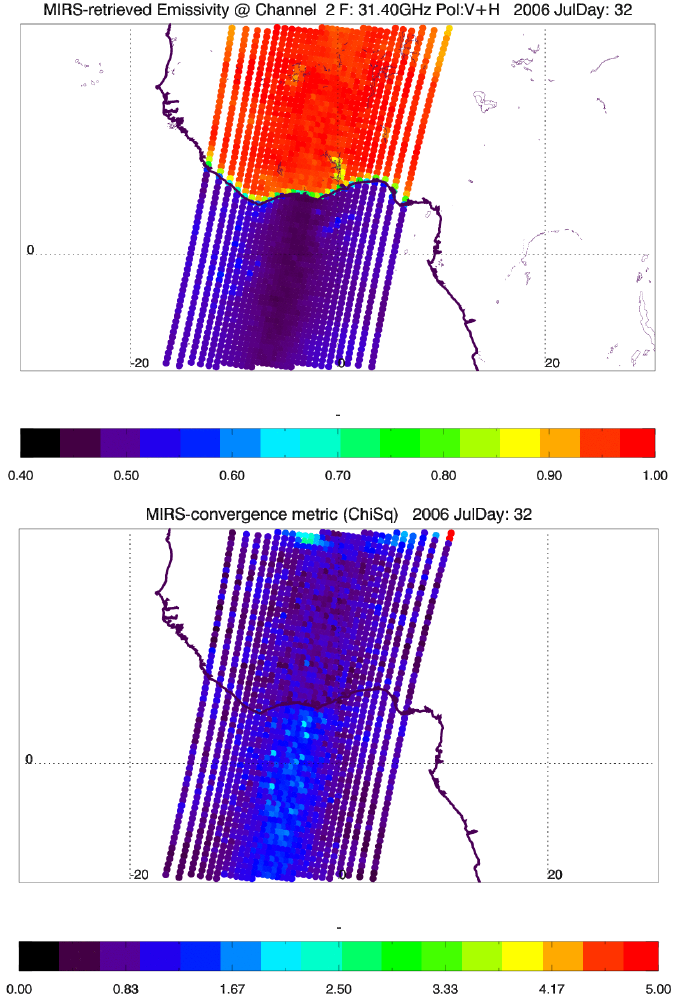
Figure 4. Qualitative assessment of the MiRS-based emissivity retrieval from NOAA-18 Advance Microwave Sensor Unit (AMSU) measurements at the transition of the Sub-Saharan African coast. (The actual emissivity retrieved from MiRS highlighting the low-to-high transition from ocean emissivities to land emissivities, as expected ( top ), all while perfectly converging ( bottom ). Note also the angle dependence of the emissivity over the ocean, as expected, is captured by MiRS